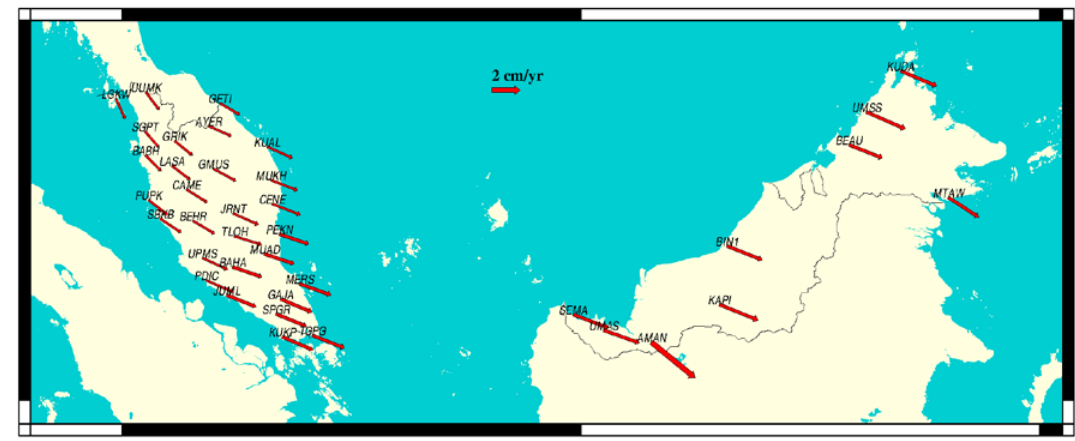
Figure 3. MyRTKnet velocity vector map for the 2008 to 2011 period. Note that fewer stations are displayed as the station names and arrows will overlap one another. As for East Malaysia, most stations began operation in April 2009; hence, they are not selected for velocity vector determination. Station AMAN has a different direction and velocity as it experiences severe subsidence